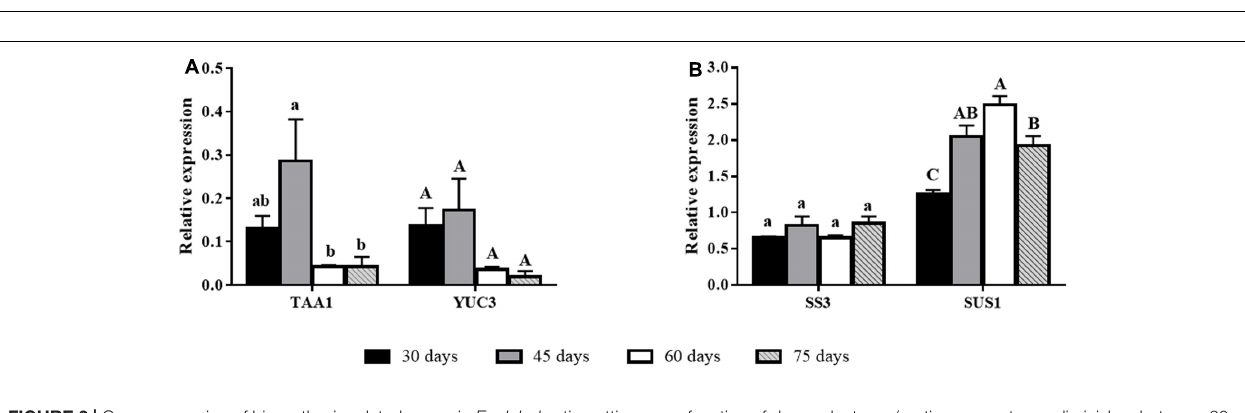
FIGURE 3 | Gene expression of biosynthesis-related genes in E. globulus tip cuttings as a function of donor plant age (rooting competence diminishes between 30 and 60 days). Black bars – 30 days, gray bars – 45 days, white bars – 60 days, diagonal line bars – 75 days. (A) Auxin biosynthesis genes TAA1 and YUC3 during aging in E. globulus . (B) Carbohydrate biosynthesis genes SS3 and SUS1 during aging in E. globulus . Expression levels genes were evaluated using qPCR and normalized against H2B and TUA as endogenous control genes. Values represent average of biological triplicates analyzed in technical quadruplicates. Bars sharing the same letters are not different according to Tukey test with P ≤ 0.05. Lines on top of bars represent standard